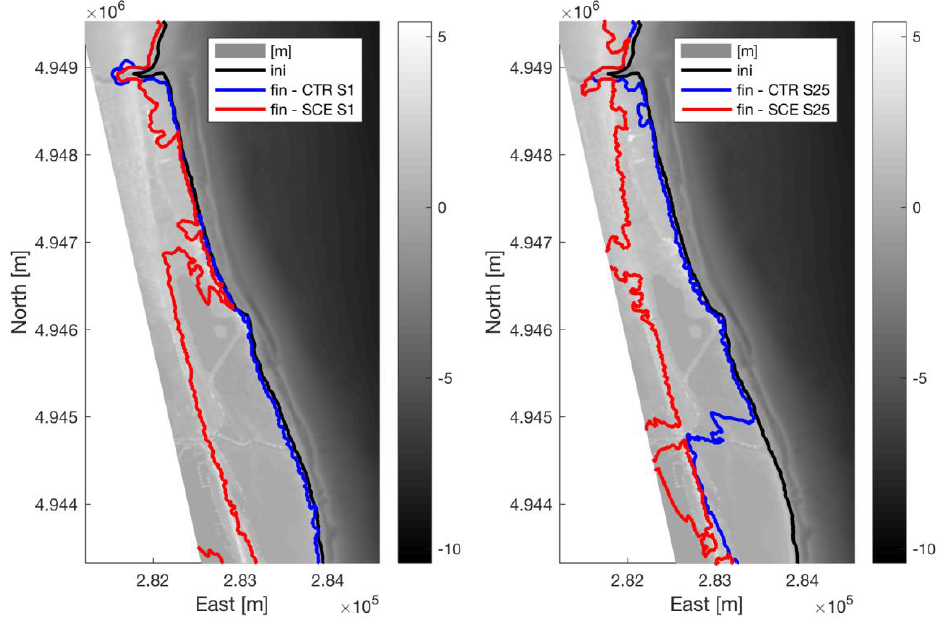
Figure 13. Sirocco events. Inundated areas for ordinary ( left panel ) and extreme ( right panel ) events and for CTR (blue lines) and SCE (red lines) scenarios. Black lines indicate the initial shoreline.